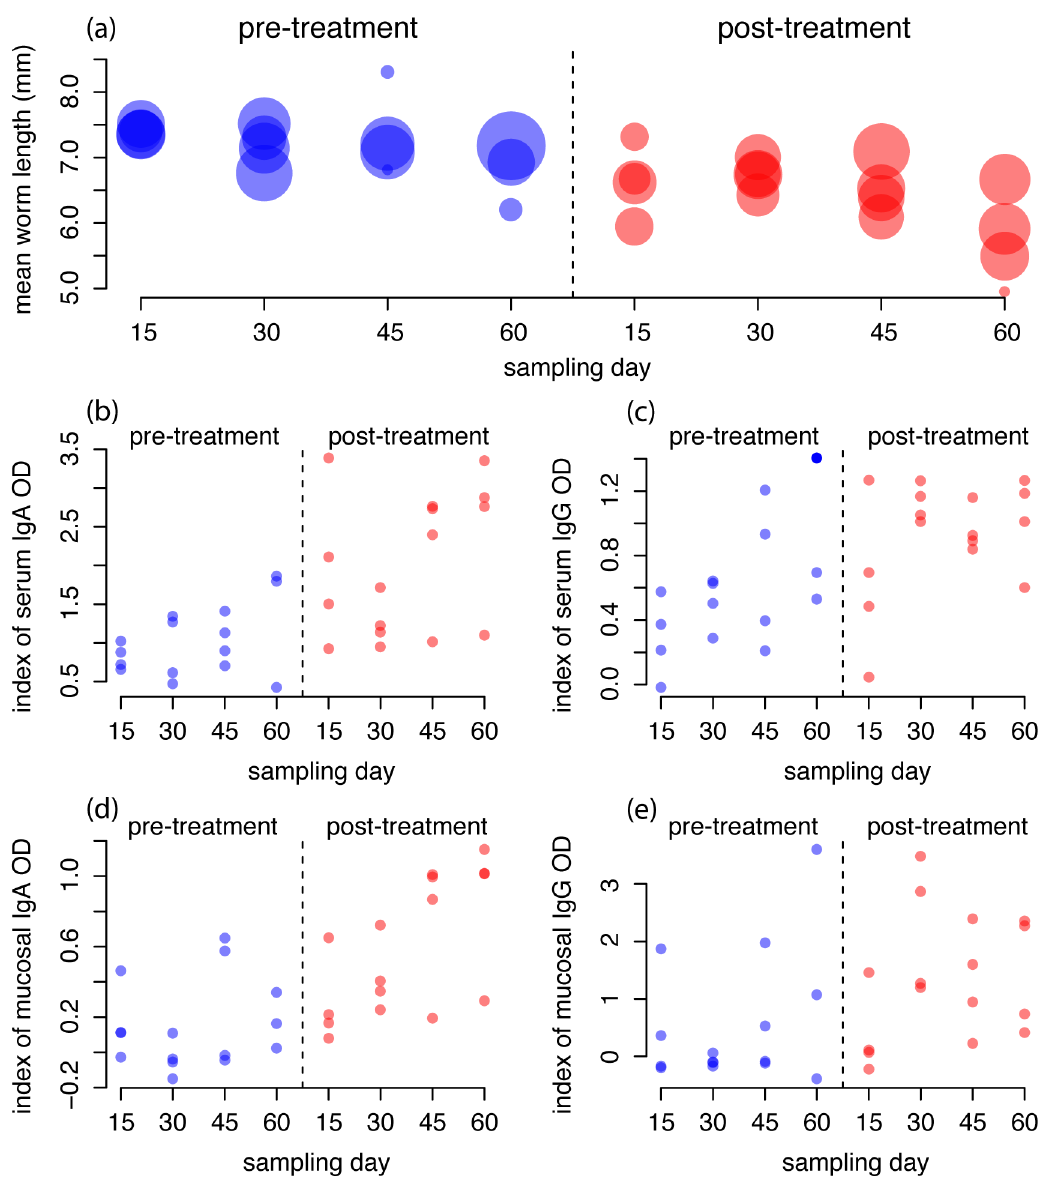
Fig 4. Mean parasite length and antibody levels over time. (a) The mean parasite length per animals at each sampling point post initial infection for the pre-treatment (left) and post-treatment (right) phases. The size of points are scaled by the square root of the number of parasites collected per animal variation in the number of worms in each rabbit. (b) The levels of serum IgA (index of optical density, see Methods) collected on the last sampling point for each animal, (c) the levels of serum IgG collected on the last sampling point for each animal, (d) the levels of mucus IgA collected on the last sampling point for each animal, (e) the levels of mucus IgG collected on the last sampling point for each animal.